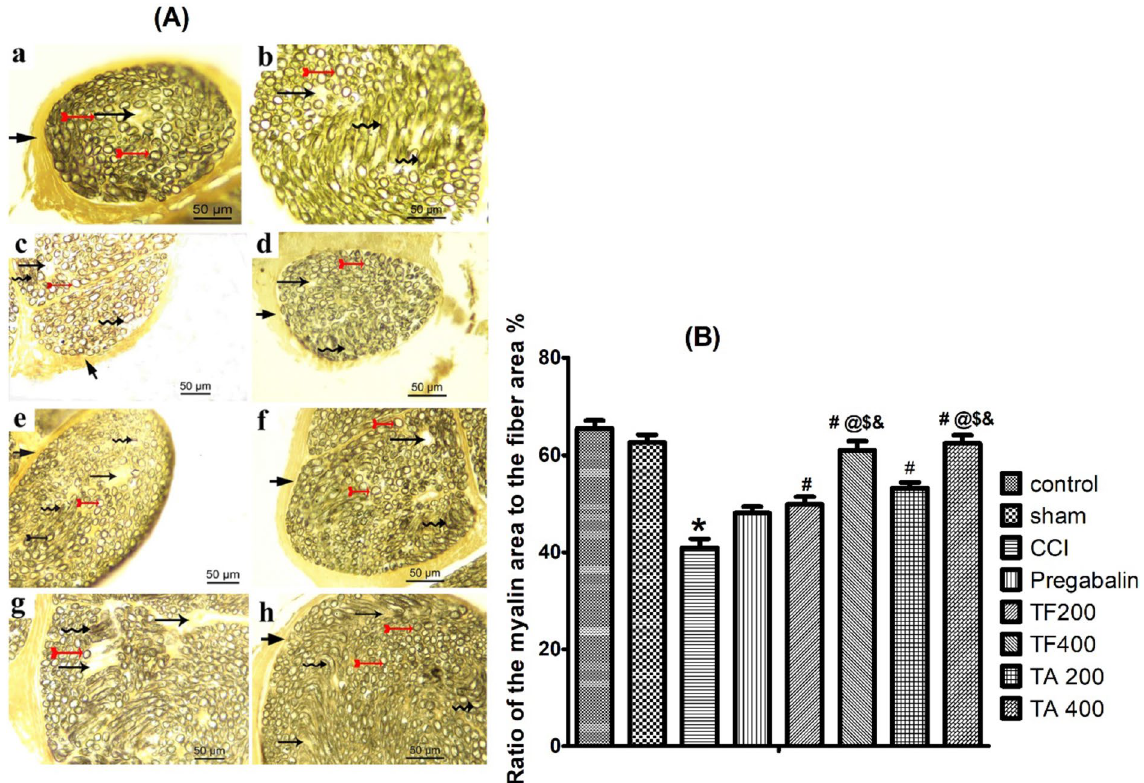
Figure 7. Representative Photomicrographs of osmic acid stained sciatic nerve transverse sections in ( A ): (a) normal group; (b) sham group; (c) CCI group; (d) pregabalin group; (e) TF (p.o., 200 mg/kg); (f) TF (p.o., 400 mg/kg). TA (p.o., 200 mg/kg); (f) TA (p.o., 400 mg/kg). Arrow, arrowhead, bifid arrow, short arrow and wavy arrow show the usual concentric lamellar structure of myelin sheath, unmyelinated nerve fibers, and irregular concentric lamellar structure of myelin sheath, respectively. Scale bar, 50 μm × 400. ( B ) Bar graph represents quantification of the ratio of myelin area to the fiber area %. Statistical analysis was performed using